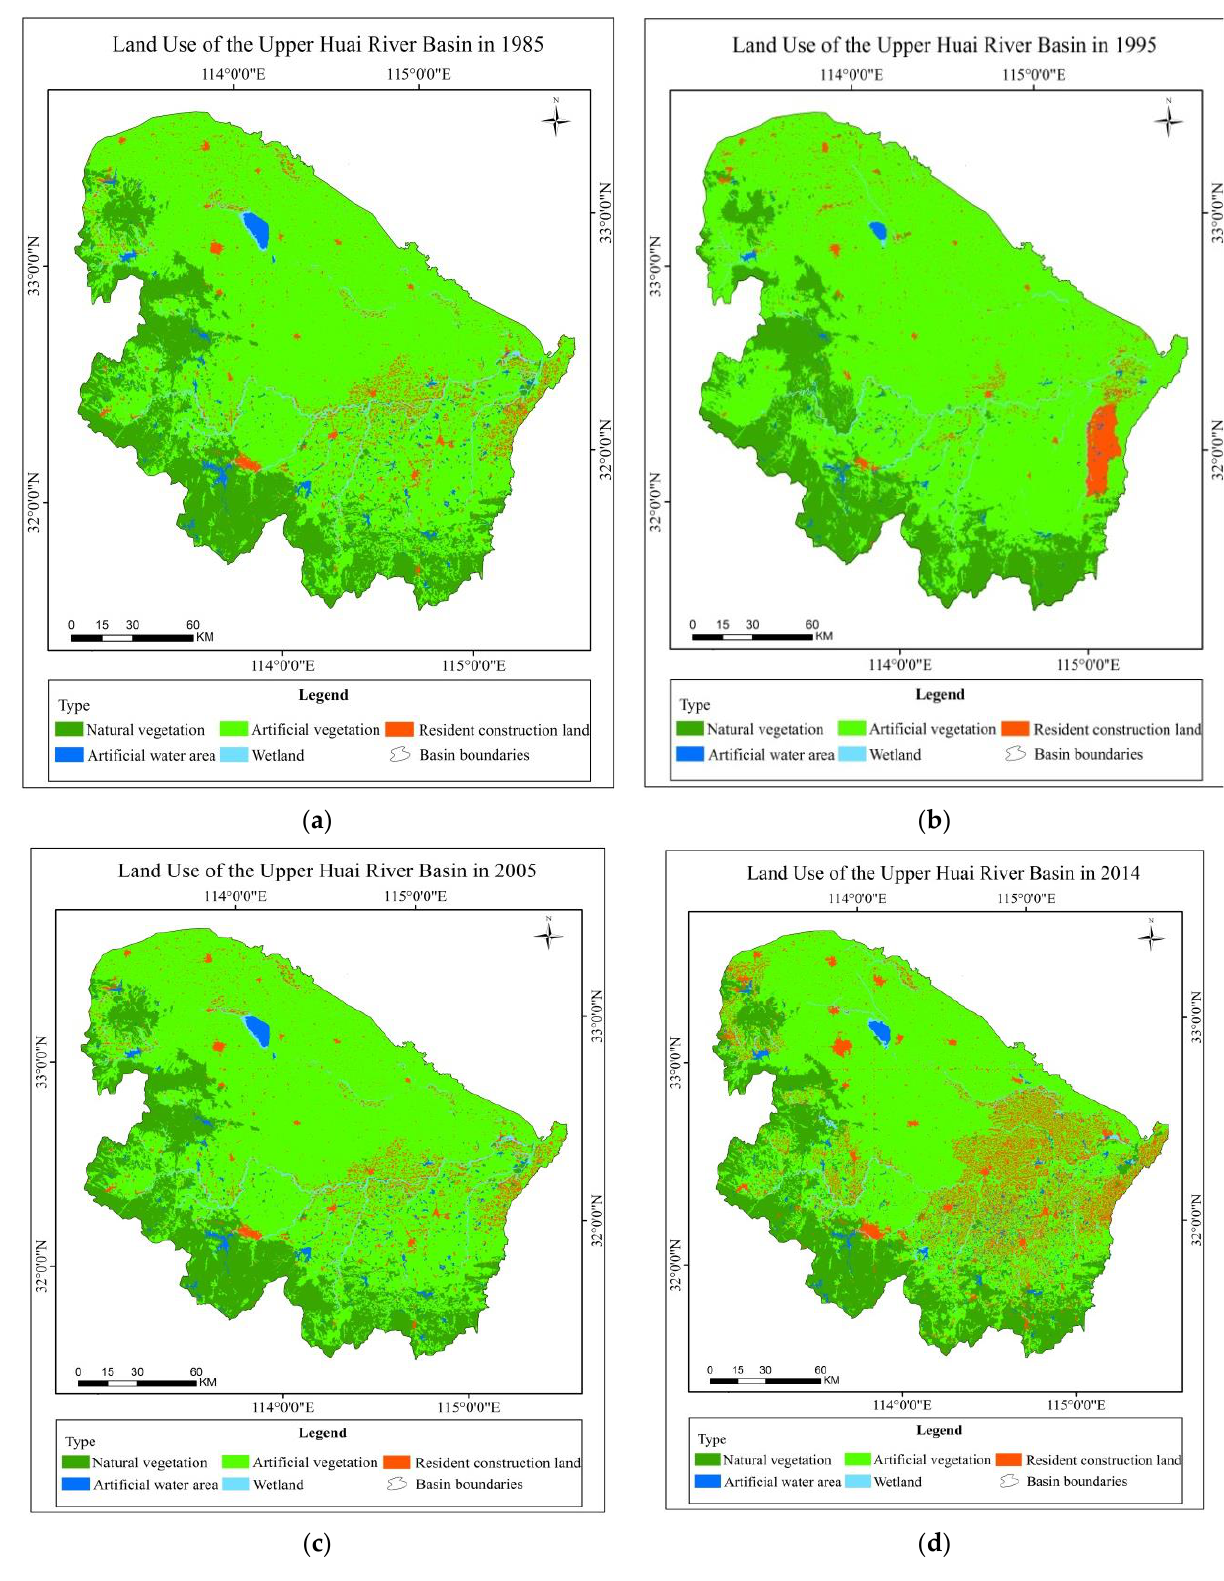
Figure 6. Study area map of land-use type by spatial transformation variation.